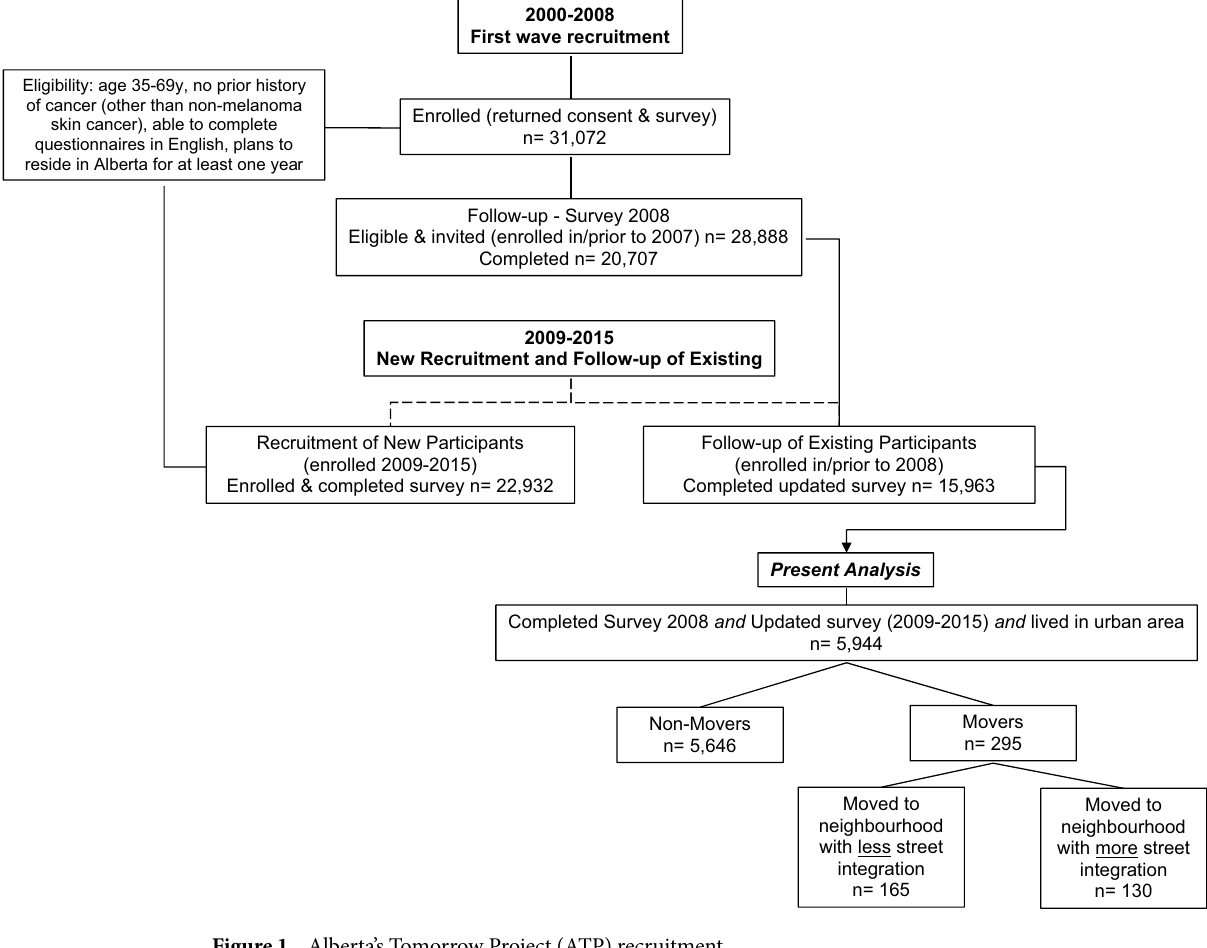
Figure 1. Alberta’s Tomorrow Project (ATP)